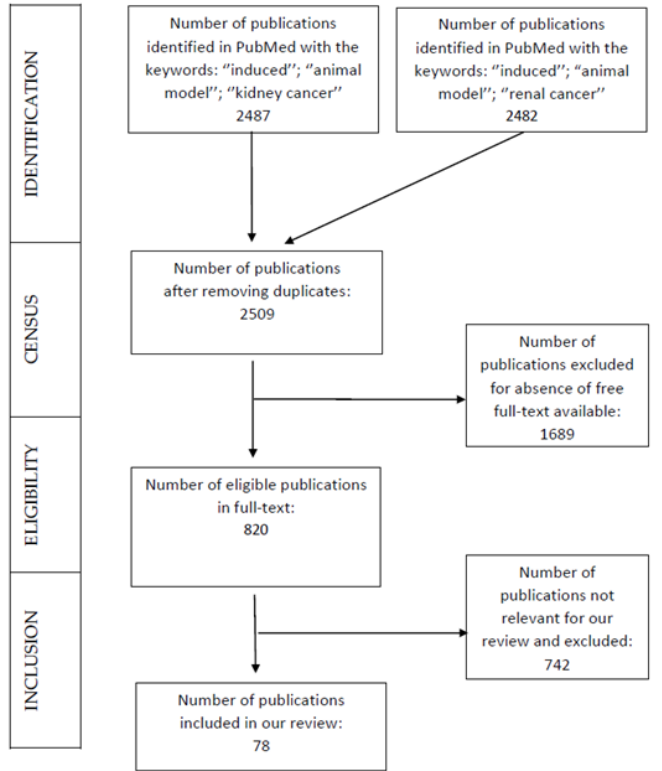
Figure 1. Selection process of the articles in our review following the PRISMA recommendations.